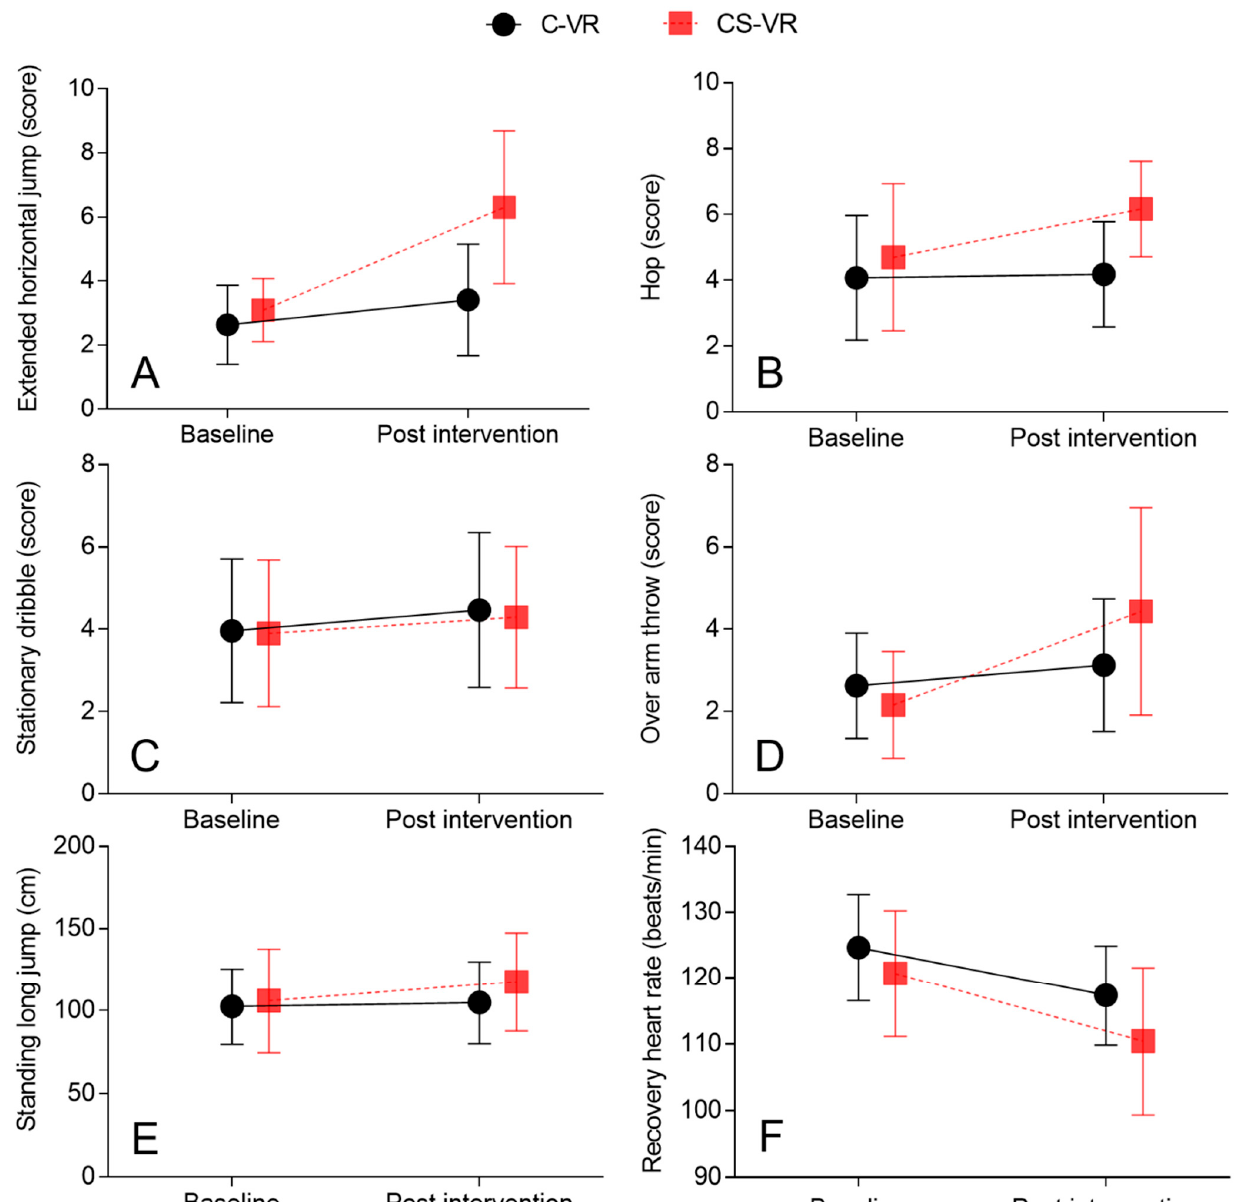
Figure 6. ( A ) Comparison of the mean of extended horizontal jump score between CS-VR and C-VR, F (1, 31) = 12.452, p < 0.01, ( B ). Comparison of the mean of hop score between CS-VR and C-VR, F (1, 31) = 6.705, p < 0.05, ( C ). Comparison of the mean of stationary dribble score between CS-VR and C-VR, F (1, 31) = 0.084, p = 0.773, ( D ). Comparison of the mean of over arm throw score between CS-VR and C-VR, F (1, 31) = 7.654, p < 0.01, ( E ). Comparison of the mean of standing long jump between CS-VR and C-VR, F (1, 31) = 11.01, p < 0.001, ( F ). Comparison of the mean of RHR between CS-VR and C-VR, F (1, 31) = 5.432, p < 0.001. Error bars indicate standard deviation (SD).